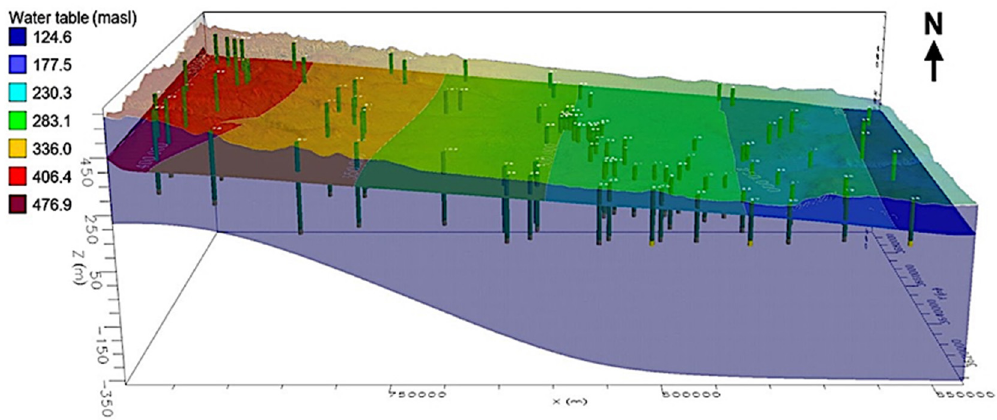
Figure 7. Observation and irrigation wells and water table modelling.